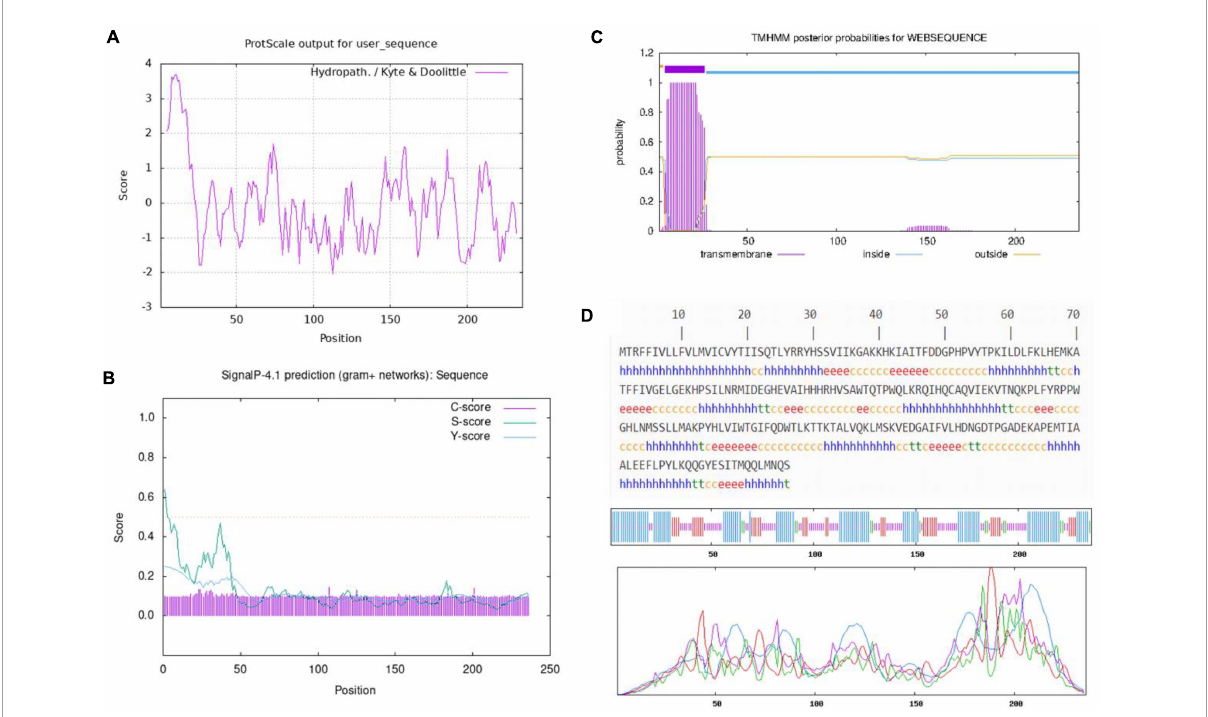
FIGURE6 Amino acid sequence analysis of the predicted CDA. (A) Hydrophilicity profile of amino acid sequence of the CDA in B. aryabhattai TCI-16, The minimum hydrophobicity of BaCDA was − 2.033, which was located at 113th amino acid (Gln); the maximum value was 3.689, which was located at 11th (Val). Overall, the protein encoded by this gene is hydrophilic. Relative weight for window edges was 100% and the weight variation model was linear. (B) Signal P prediction of amino acid sequence of the CDA in B. aryabhattai TCI-16. The prediction of the N-terminal signal peptide from the amino acid sequence shows that the protein has no signal peptide. (C) Transmembrane helices prediction of the CDA in B. aryabhattai TCI-16. (D) Secondary structure of the CDA in B. aryabhattai TCI-16. The letter h denoted the alpha-helical structure, the irregular coil structure was denoted by c, t was the beta-turn structure, and e was the extended strand.